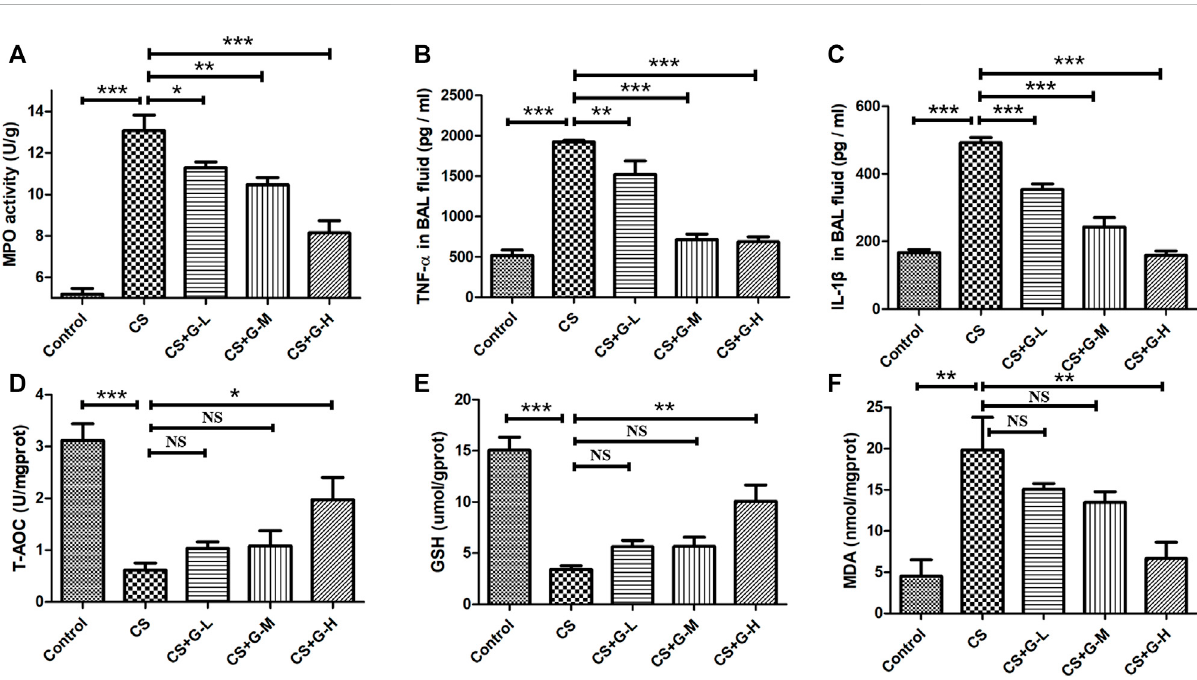
FIGURE 3 Treatment with GHK-Cu ameliorated lung in fl ammation and oxidative stress induced by cigarette smoke. (A) MPO activity in lung tissue was assessed following chronic exposure to cigarettesmoke or room air. (B,C) Proin fl ammatory cytokines, including TNF- α (B) and IL-1 β (C) , in BAL fl uid supernatant were measured by ELISA ( n = 6 mice/group). (D – F) The levels of T-AOC (D) , GSH (E) and MDA (F) in lung homogenate were detected in mice of different groups ( n = 3 mice/group). * p < 0.05, ** p < 0.01, *** p < 0.001, and NS means not signi fi cant ( p >